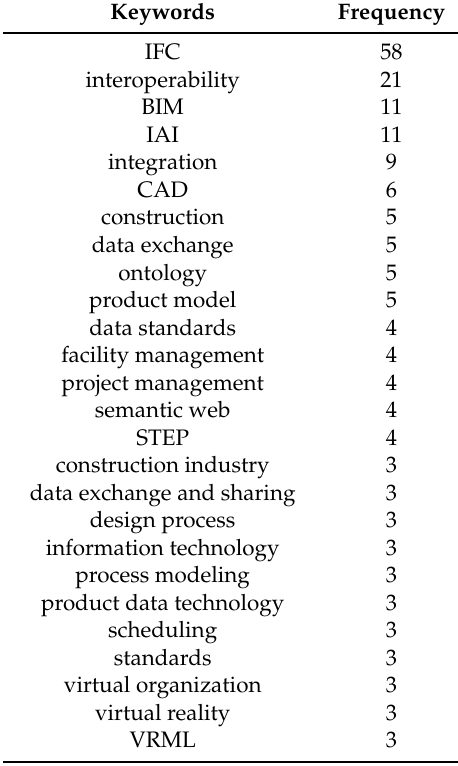
Table 5. Frequency ranking of all keywords that appeared in at least three publications.